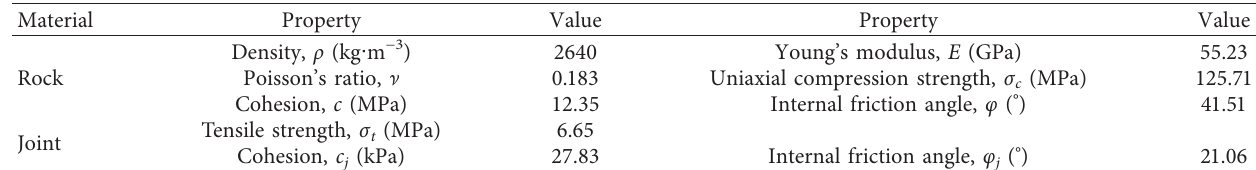
Table 4: Mechanical properties of Shuichang open-pit iron mine granite from laboratory tests.